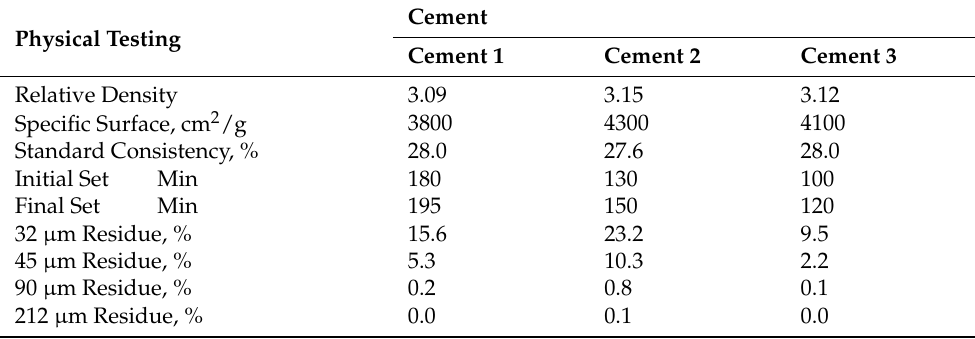
Table 2. Physical properties of the cement used.